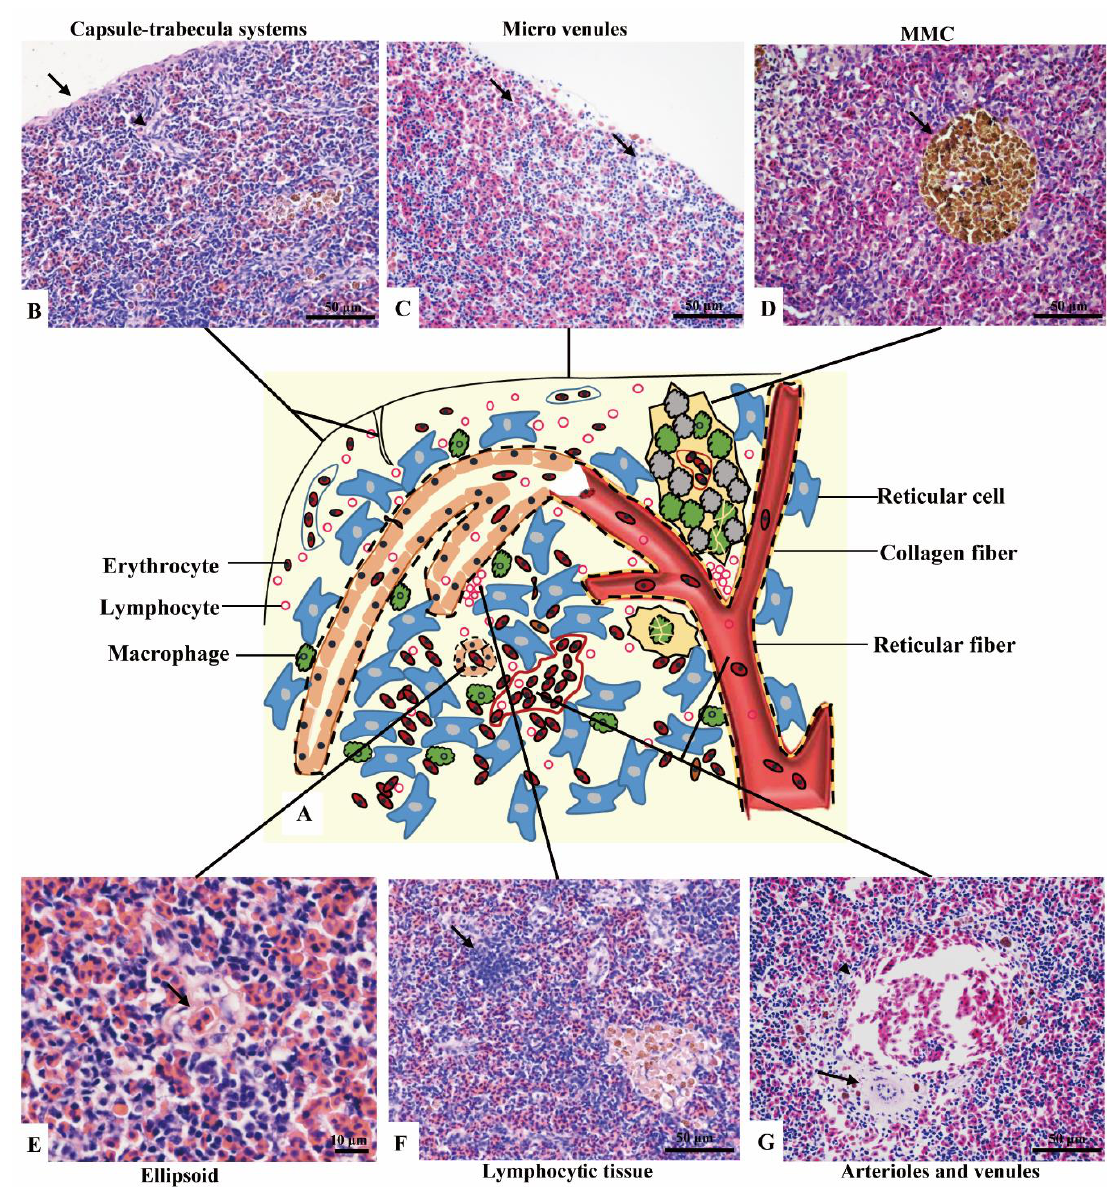
Figure 2. The components of the spleen (H&E staining). ( A ). A schematic representation of spleen; ( B ). The splenic capsule-trabecula systems, showing thin capsule ( → ) and poorly developed trabecular ( ▲ ); ( C ). The micro venules ( → ) underneath the capsule, consisted of a signal layer of flat endothelial cells with a capacity of 4 – 6 erythrocytes; ( D ). The MMC ( → ) brown-black color, sub-circular shape, and surrounded by a single layer of flat cells; ( E ). The ellipsoid ( → ) consisted of cuboidal-shaped endothelial cells; ( F ). A small cluster of lymphocytes ( → ) in the middle layer; ( G ). An arteriole ( → ) and a venule ( ▲ ) of the inner layer.